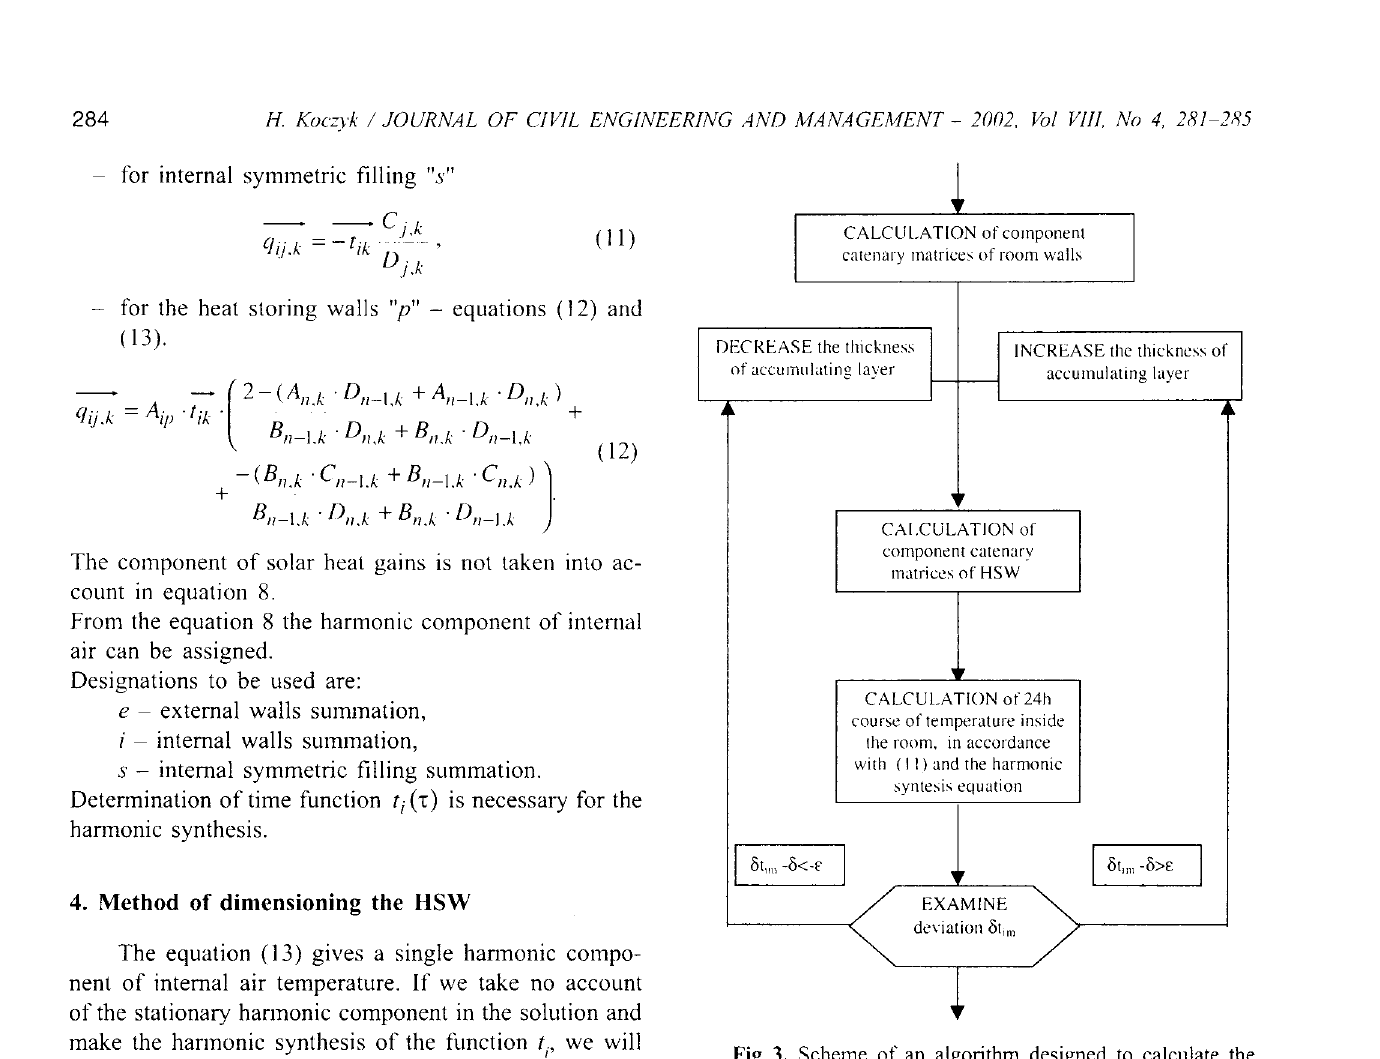
~ Fig 3. Scheme of an algorithm designed to calculate the thickness of the accumulating layer in a HSW ties of a HSW, eg: density p, or heat capacity c of the accumulating